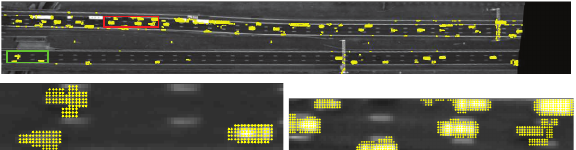
Figure 6: Identified vehicles in the image 100 (top), the zoomed area depicted by a green rectangle (bottom left), the zoomed area depicted by a red rectangle (bottom right). Figure 7. The statistics come in Table 1 for fluid traffic and in Table 2 for congested traffic. All validation is based on careful visual inspection of the results.